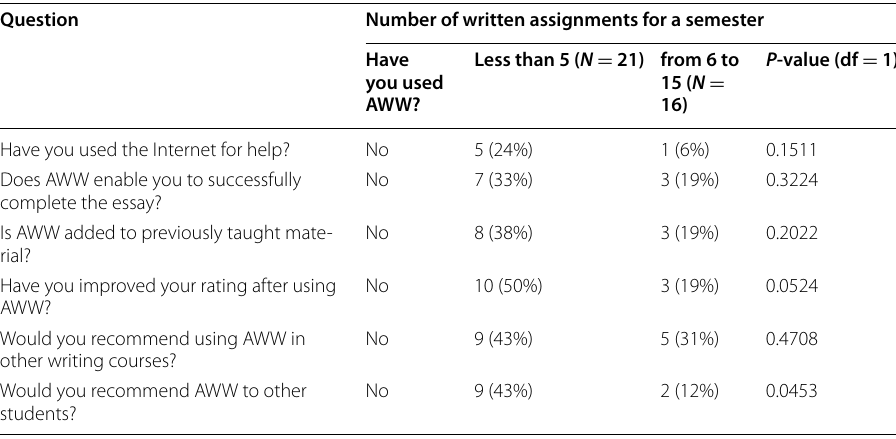
Table 13 Comparison of binary questions by number of written assignments for a semester Question Number of written assignments for a